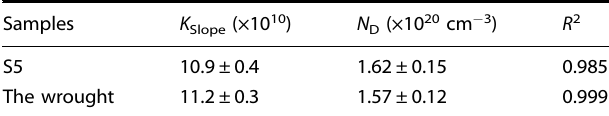
Table 2. Fitting parameters of Mott – Schottky plots and the calculated values of N D for S5 and the wrought